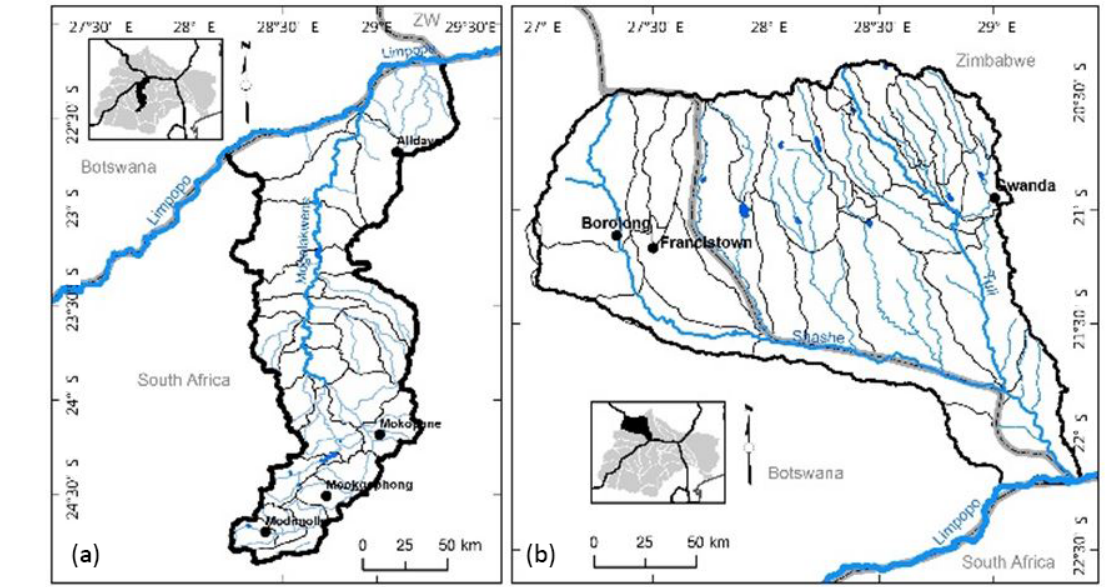
Figure 1. Map of the Mogalakwena (a) and Shashe (b) sub-basins and their locations in the Limpopo River